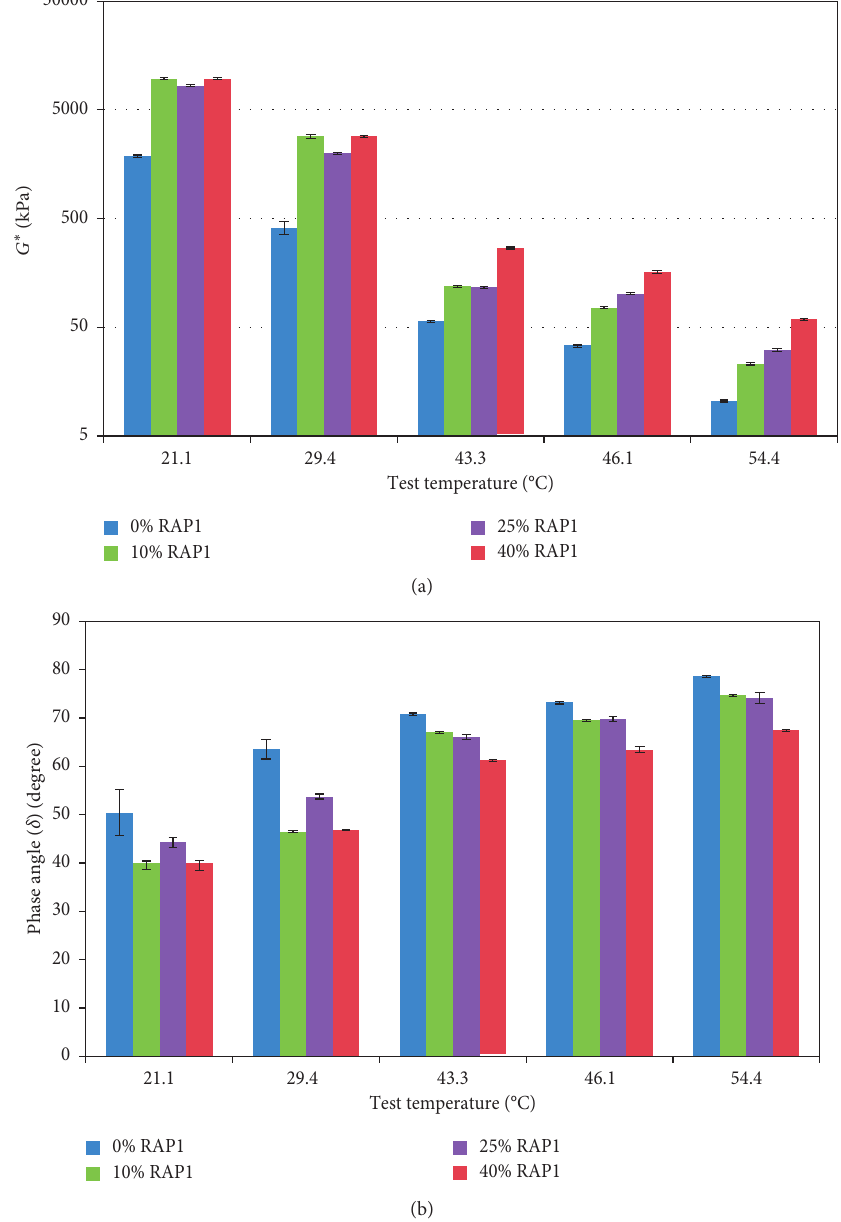
Figure 2: MEPDG input parameters based on DSR tests: (a) G ∗ and (b) phase